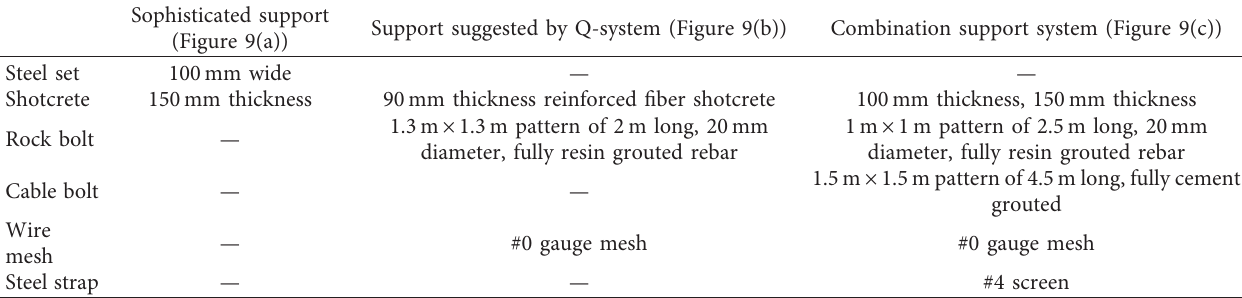
Table 5: Detailed design parameters of different support systems.